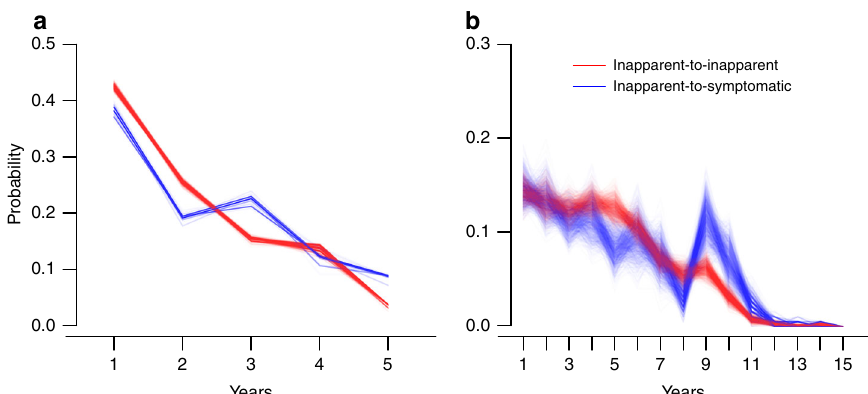
Fig. 4 Posterior distribution of the time interval between consecutive infections. Results are colored in red for the time between inapparent infections and in blue for the time between an inapparent infection and a symptomatic infection. a Estimation is restricted to infections that occurred during the study. b Estimation is based on the proposed method combining the study period and the years before study entry. Source data are provided as a Source Data fi